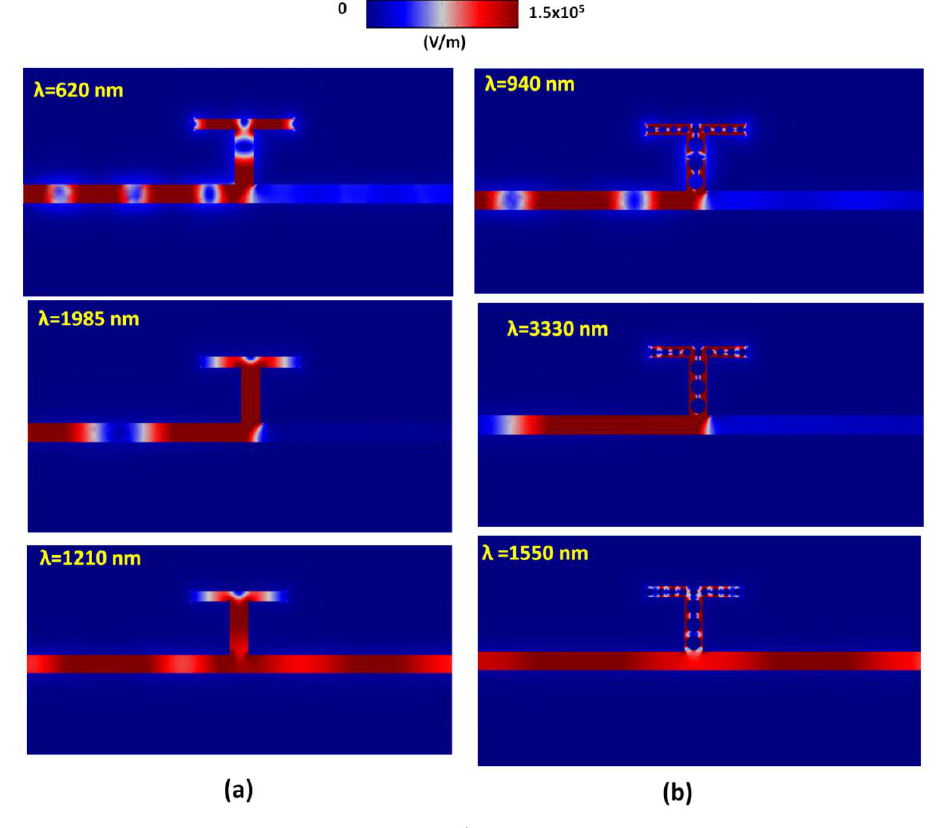
Figure 4. Electric field intensity ( | E | = (E x 2 + E y 2 ) 1 / 2 ) for the cases ( a ) without defects (at λ res = 620 nm, 1985 nm and 1210 nm) and ( b ) with defects (at λ res = 940 nm, 3330 nm and 1550 nm), respectively.